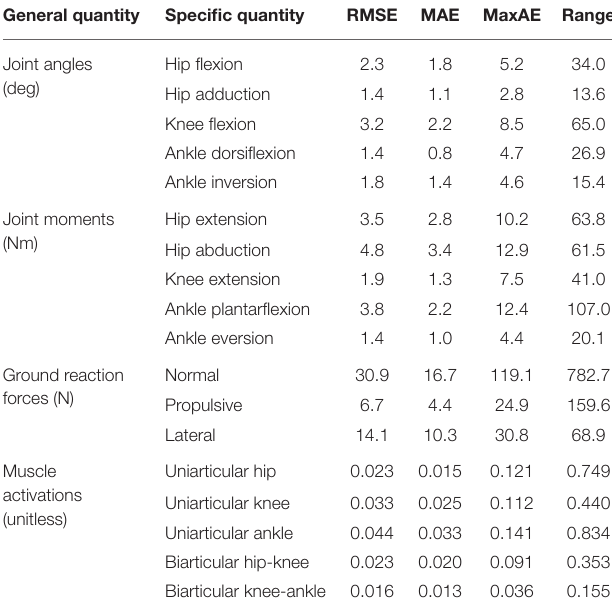
TABLE 5 | Root-mean-square error (RMSE), mean absolute error (MAE), maximum absolute error (MaxAE), and range in joint angles, joint moments, ground reaction forces, and muscle activations from the verification optimal control problem.